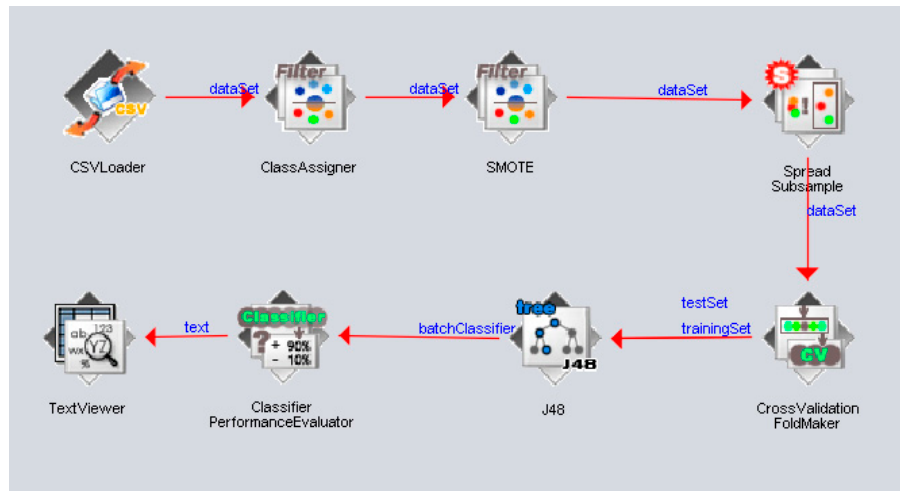
Figure 7. The design of the process from loading the dataset, to training and testing using machine learning algorithms and the performance classification using the WEKA Knowledge Flow module.